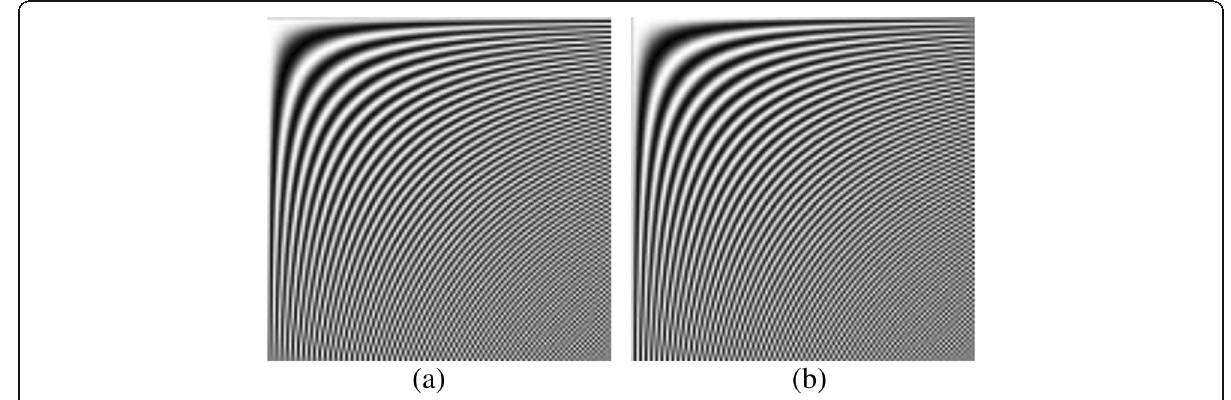
Fig. 1 Illustration of DCT transform matrices. a Forward transform matrix, and b inverse transform